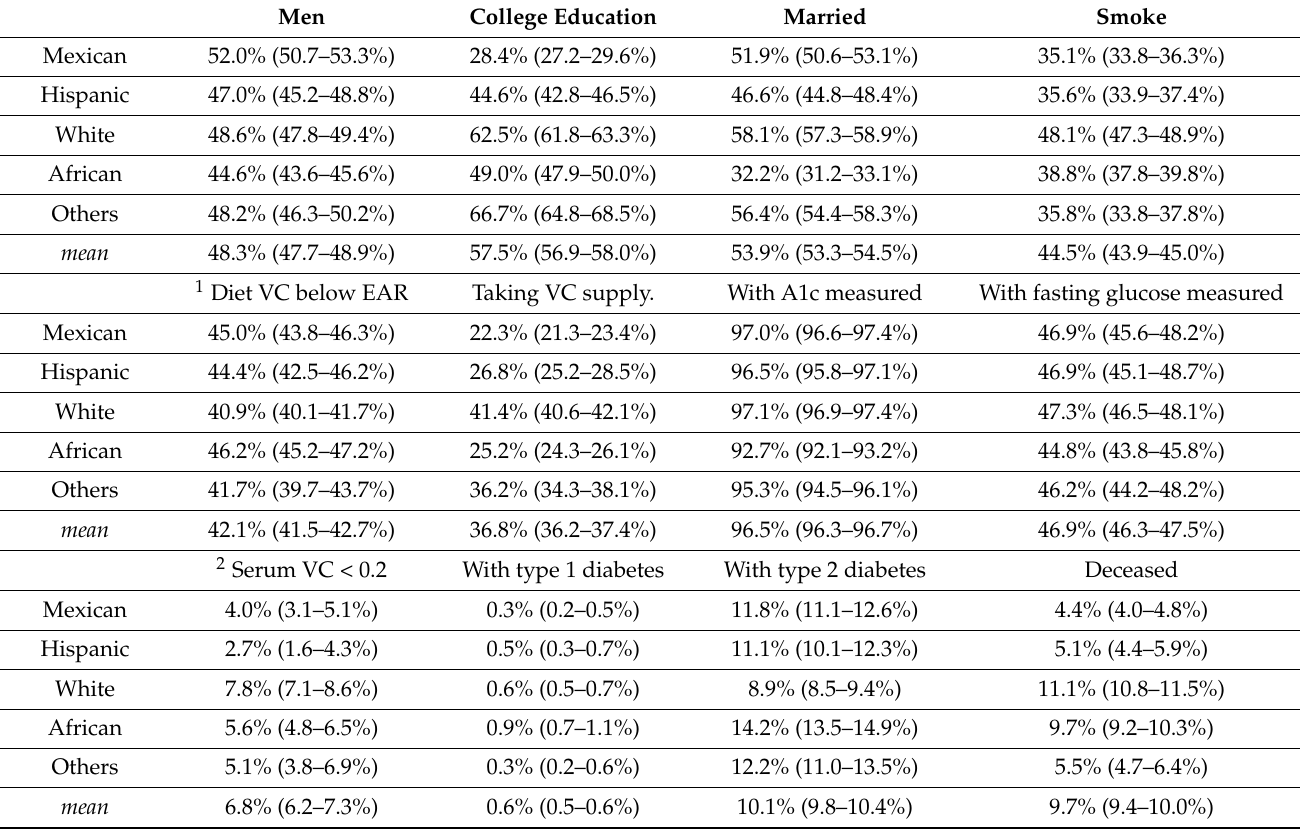
Table 1. Mean percentages of demographic and covariates data and their 95% confidence interval (inside